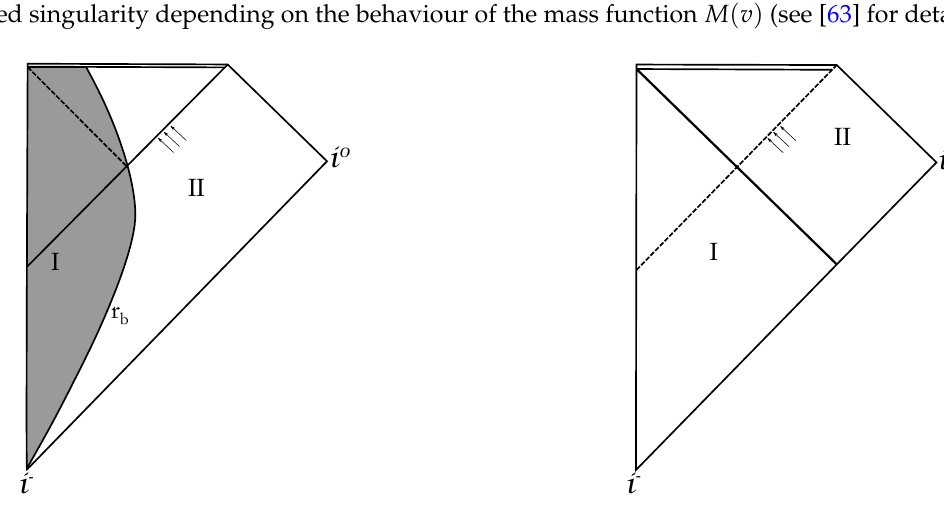
Figure 1. Penrose diagrams for collapse with the formation of a singularity (double solid line). Left panel : Collapse of a spherical dust cloud. The solid curved line r b represents the boundary of the cloud. The interior region I, is described by pressureless particles (grey area), the exterior region II, is described by the Schwarzschild vacuum space-time. As the boundary passes the Schwarzschild radius the trapped region develops. In the exterior the event horizon (solid diagonal line) forms at r = 2 M , while in the interior the apparent horizon (dashed line) moves inwards from the boundary towards r = 0. Right panel : Collapse of a thin null shell (thick line) separating a Minkowski interior, region I, from a Schwarzschild exterior, region II. The event horizon (dashed line) meets the collapsing shell at the Schwarzschild radius. The null fluid focuses at the center forming a singularity at r =